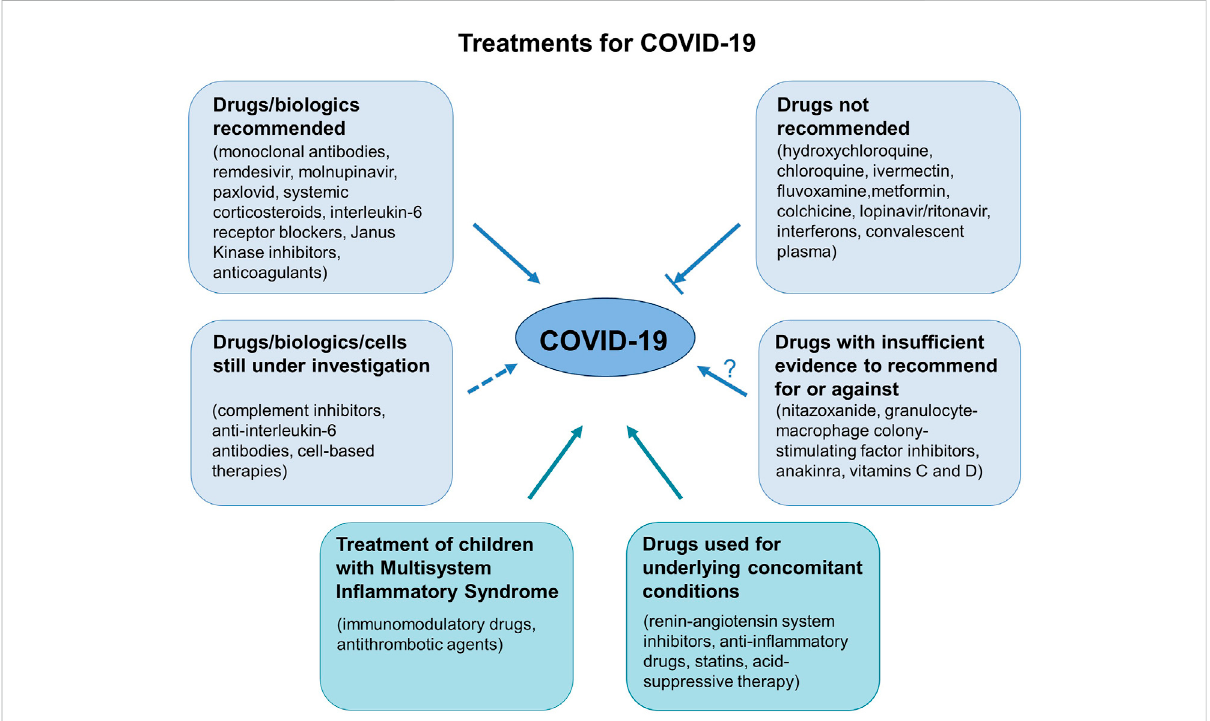
FIGURE 4 Summary of treatment spectrum for COVID-19. The panel shows drugs/biologics recommended or not recommended for treating patients with COVID-19. There are also medicines for which there is insuf fi cient evidence to recommend for or against their use in these patients, as well as drugs/biologics and cell-based therapies that are under investigation. Concomitant medications used to treat underlying conditions in COVID-19 patients should also be taken into consideration for safety reasons. Managing treatment for children with Multisystem in fl ammatory syndrome, an illness that is temporally associated with preceding SARS-CoV-2 exposure is also